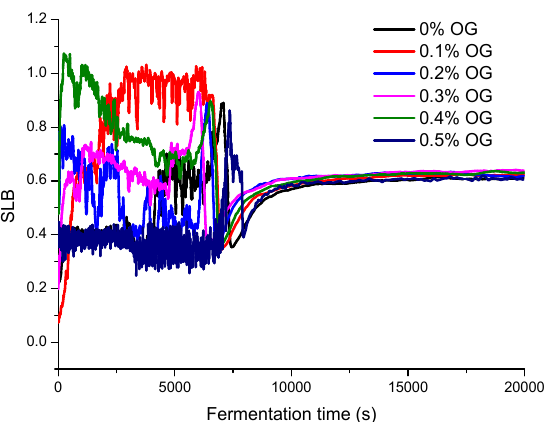
Figure 4. The SLB value curve of set-type yogurt with different OG concentrations (0%, 0.1%, 0.2%, 0.3%, 0.4%, and 0.5%) during fermentation.